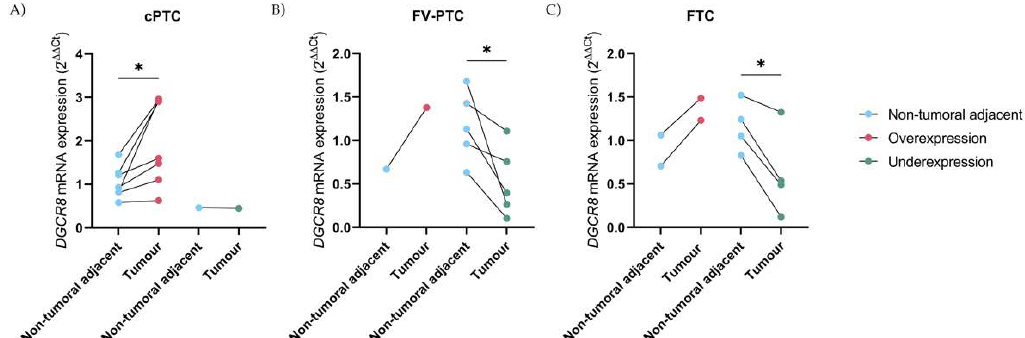
Figure 2. DGCR8 mRNA pairwise-matched tumour/NTAT analysis in cPTC( n = (8), FV-PTC ( n = 6) and FTC ( n = 6): ( A ) cPTC is characterized by overexpression and with significant difference in DGCR8 expression ( p = 0.02); ( B ) In contrast to cPTC, in FV-PTC underexpression is more frequent and DGCR8 loss of expression is significant between tumours/NTAT ( p = 0.04); ( C ) DGCR8 mRNA pairwise-matched tumour/NTAT expression in FTC cases. Four out of six cases presented a significant reduction in DGCR8 expression ( p = 0.02). * Paired t -test statistical significance p < 0.05.